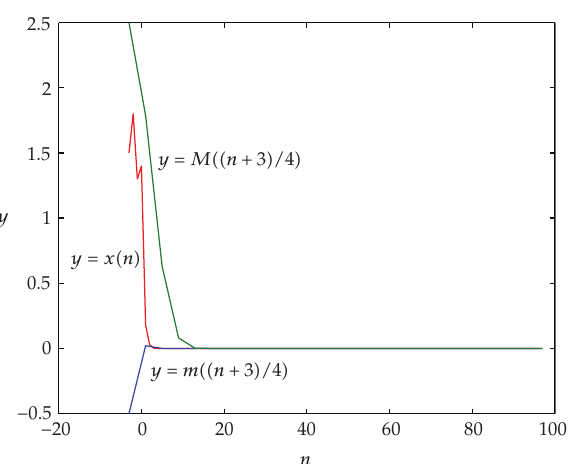
Figure 2: Chart of (cid:5) 4.2 (cid:6) with x (cid:5) − 3 (cid:6) (cid:4) 1 . 5 , x (cid:5) − 2 (cid:6) (cid:4) 1 . 8 , x (cid:5) − 1 (cid:6) (cid:4) 1 . 3 , x (cid:5) 0 (cid:6) (cid:4) 1 . 4